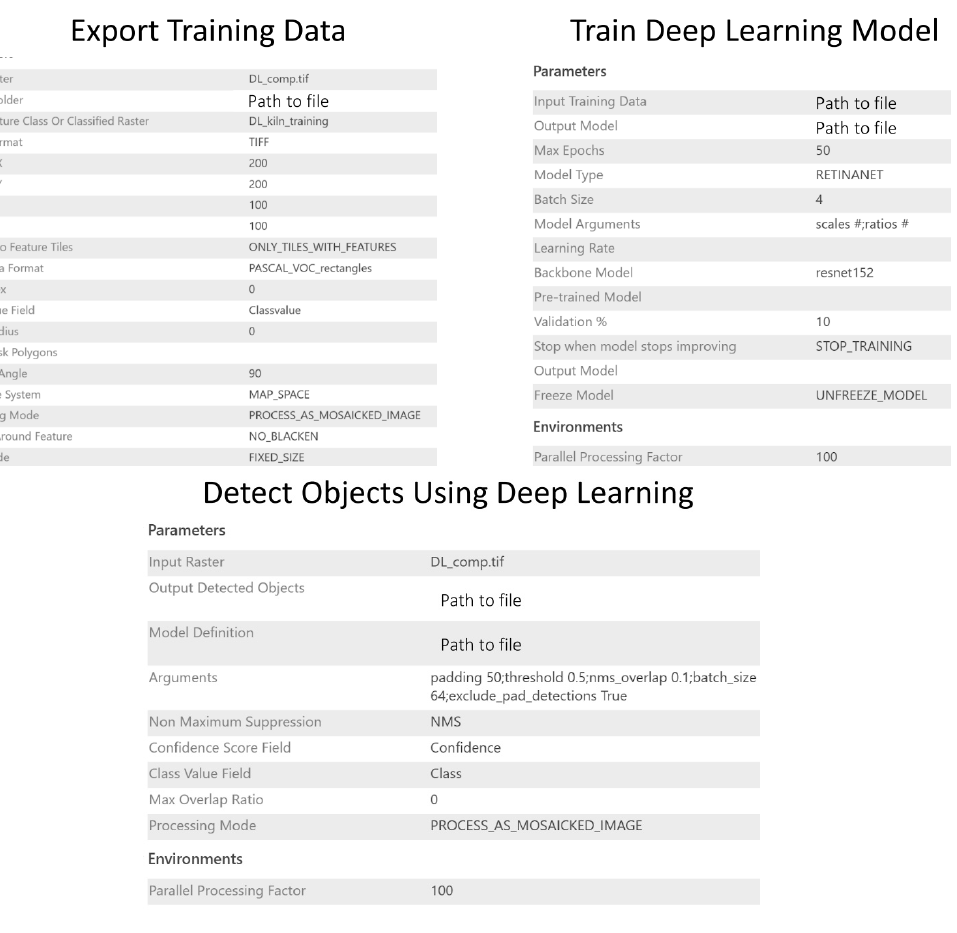
Figure 5. ArcGIS tool settings for deep learning implementation. For the Training Deep Learning Model Tool, the ResNet backbone was changed from ResNet 34, ResNet50, ResNet101, and ResNet152 for each of the models reported below.